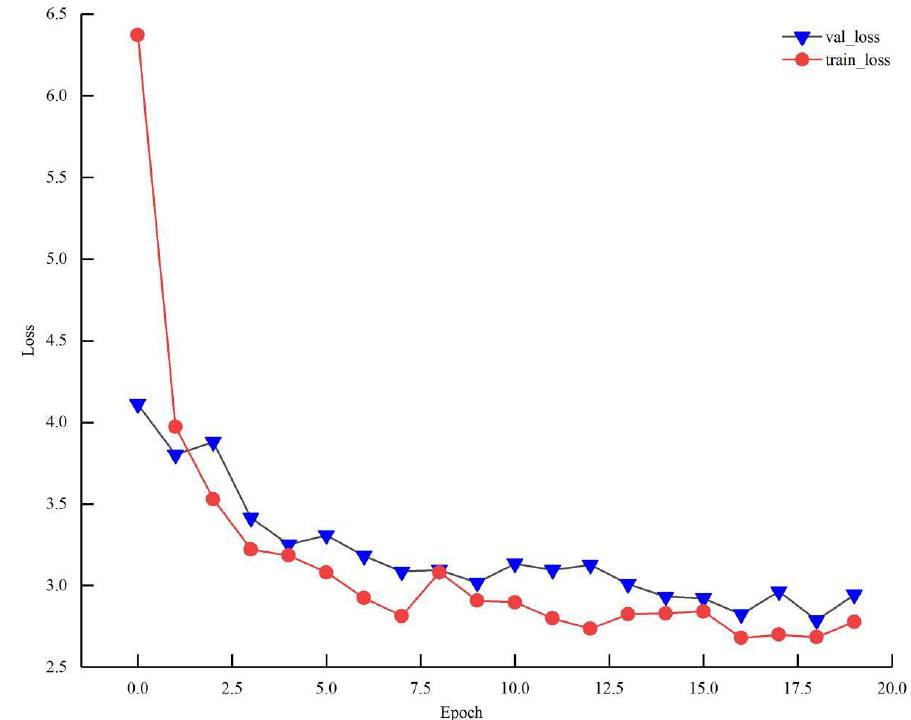
Figure 4. Loss function curve of Panicle-Mask.